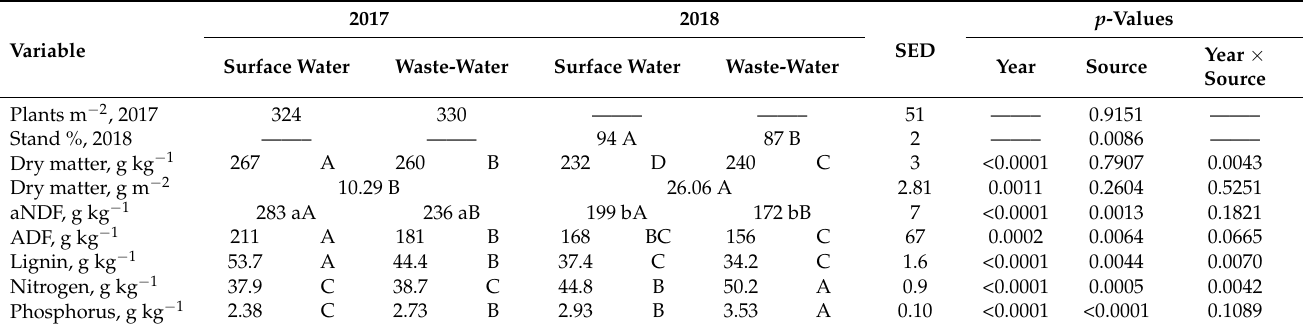
Table 6. Alfalfa plant counts, stand percentage, dry matter production, and selected plant chemical components after planting and one year after alfalfa establishment when irrigated with surface water or treated municipal wastewater (Class 1B, UV-irradiated). Values are the means of four replicates within each water source strip plot each